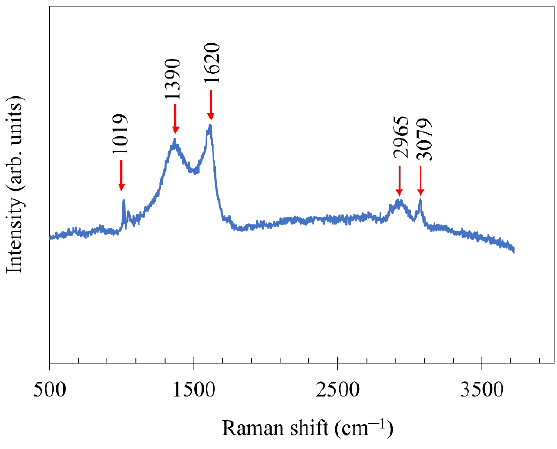
Figure 5. Raman spectrum of hybrid C/GFRP.